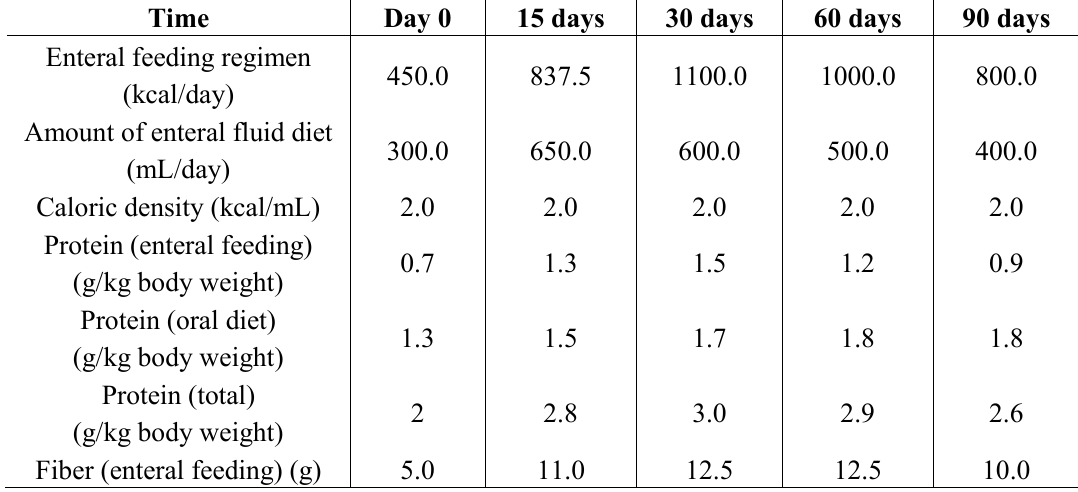
Table 2. Treatment of 10 anorexia nervosa patients with extreme undernutrition a